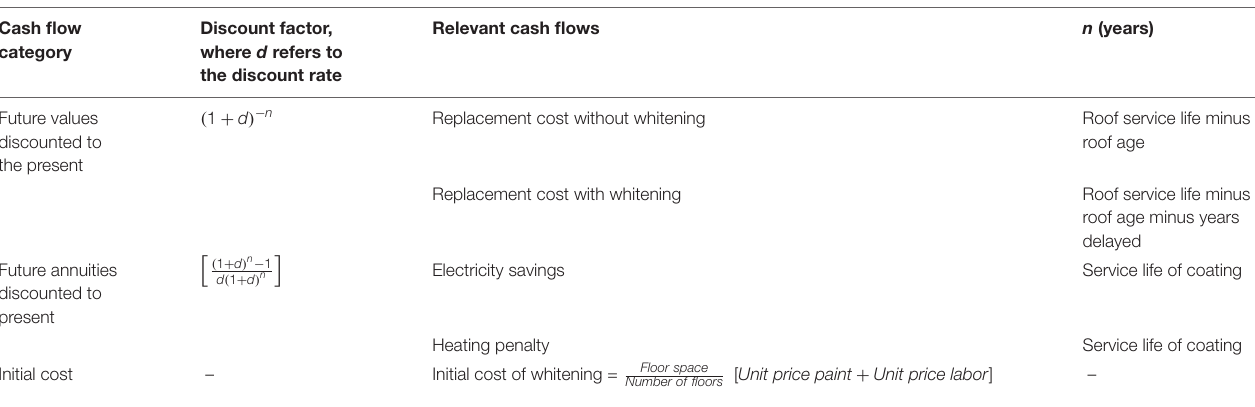
TABLE 3 | Summary of the cash flow discounting used in the life-cycle cost